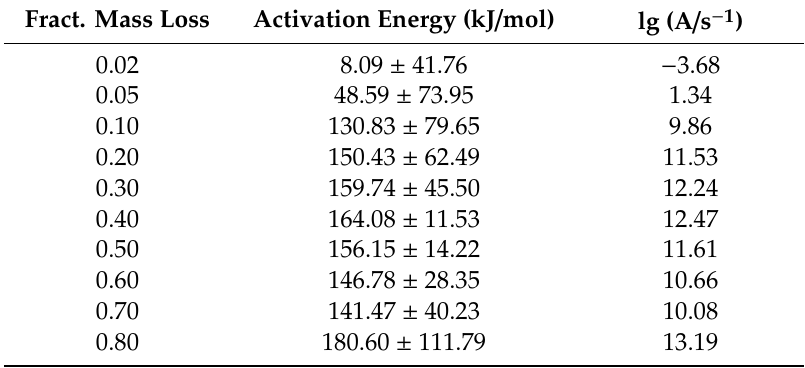
Table 2. Activation energy and pre-exponential coe ffi cient as a function of the degree of conversion by the Ozawa–Flynn–Walla method for an oat straw